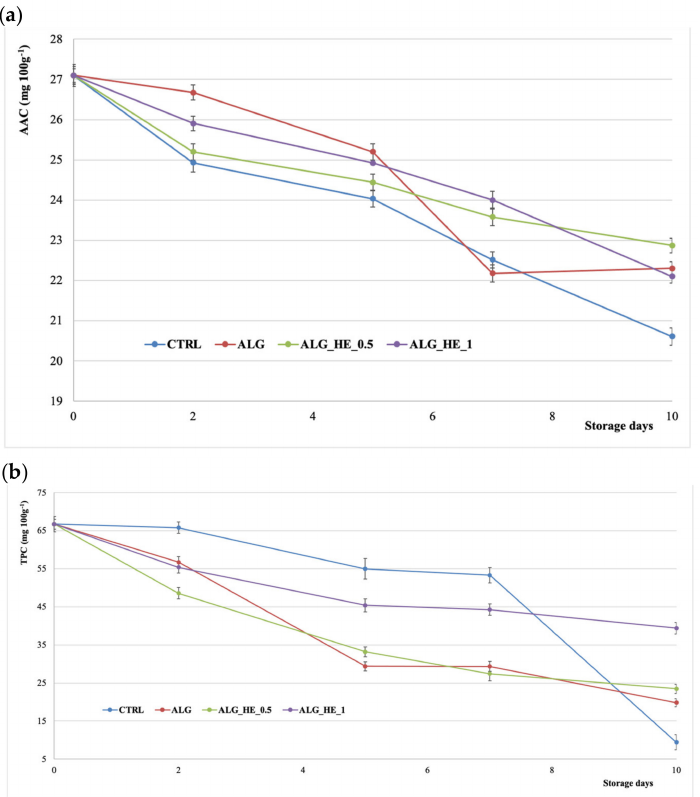
Figure 6. Changes in ( a ) ascorbic acid content (AAC) and ( b ) total polyphenol content (TPC) of fresh-cut kiwifruit underwent different treatments during storage at 4 ◦ C (mean ± sd; n = 5). CTRL, control samples; ALG, alginate samples; ALG_HE_0.5, samples coated with alginate added with 0.5% of hop extract; ALG_HE_1, samples coated with alginate added with 1% of hop